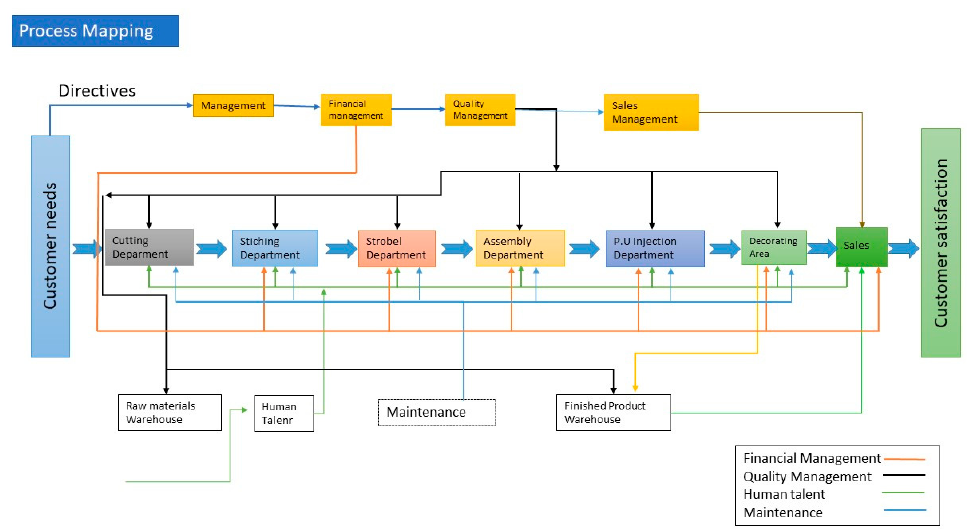
Figure 2. Process mapping elaborated by the author. The colors represent the flow of materials and information by the department.